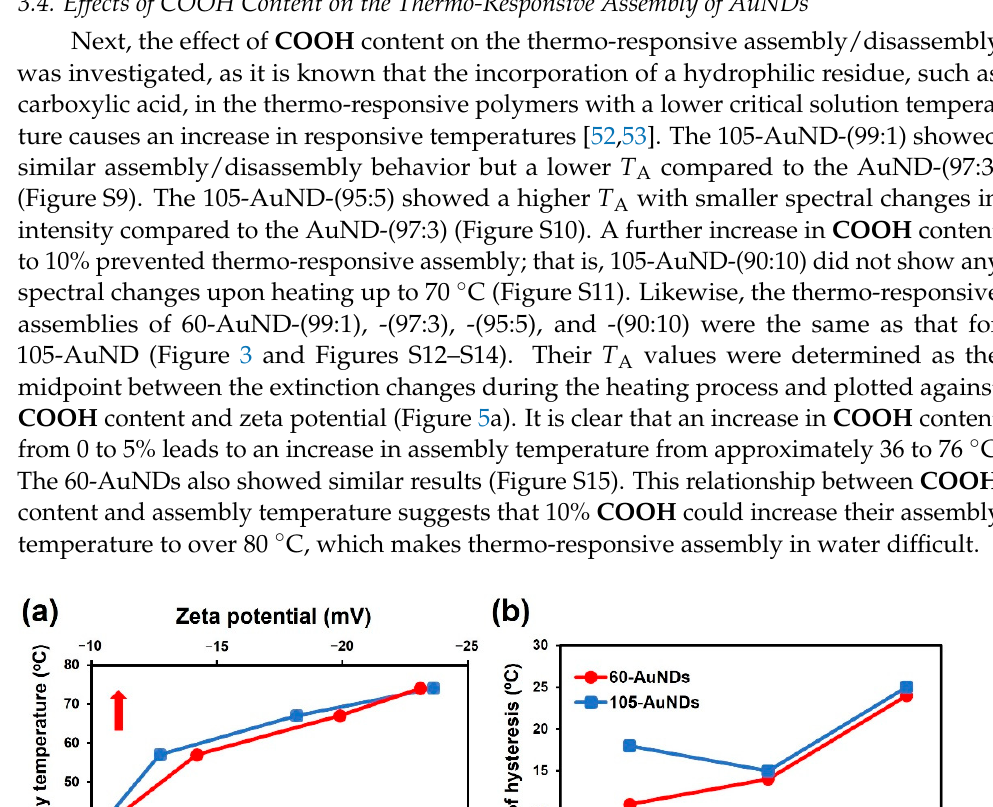
Figure 4. Thermo-responsive assembly of 40-AuNS-(100:0): ( a ) the extinction spectra of 40-AuNS- (100:0) upon heating from 25 to 70 °C and ( b ) upon cooling from 70 to 25 °C; ( c ) the extinction values at 530 nm against temperature changes. The red arrows in ( a , b ) indicate the plasmon peak changes.